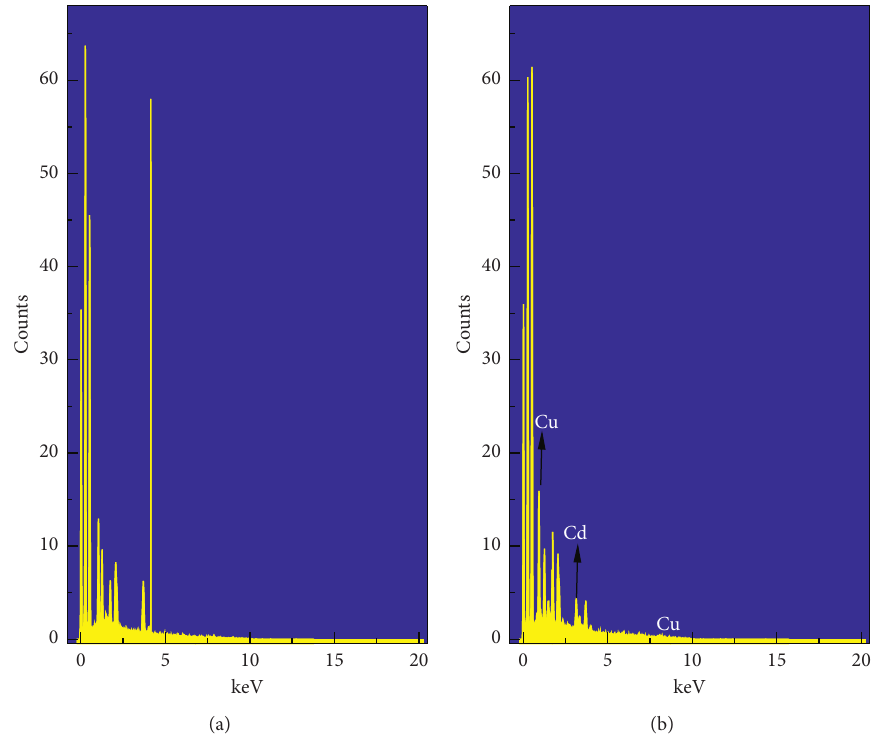
Figure 4: EDS spectra of SACL (a) before and (b) after adsorption of wastewater Cu (II) and Cd (II). Table 2: Elemental mass ratio before and after SACL adsorption in EDS